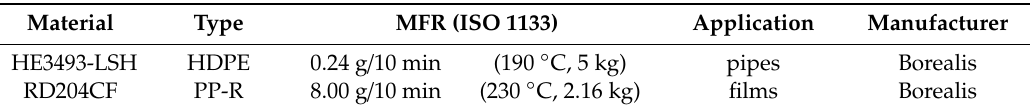
Table 1. Comparison of the materials. HDPE: high-density polyethylene; PP-R: polypropylene random copolymer; MFR: melt flow rate.